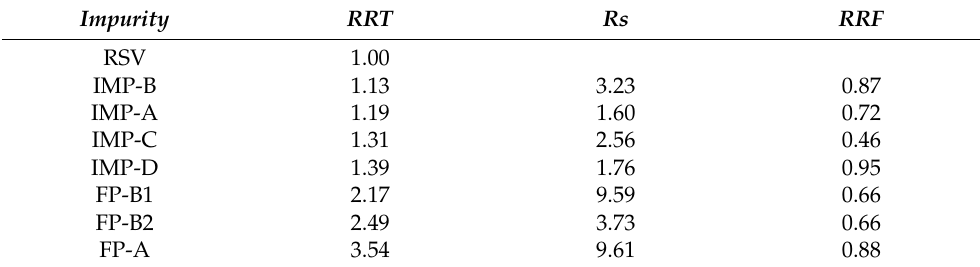
Table 1. Relative retention times ( RRT ) of RSV and its impurities, resolution factors ( Rs ) (resolution between two adjacent peaks) and relative response factors ( RRF ). Chromatographic conditions: column, Acquity BEH C18 (100 mm × 2.1 mm, 1.7 µ m); mobile phase, MeOH-TFA 0.025%